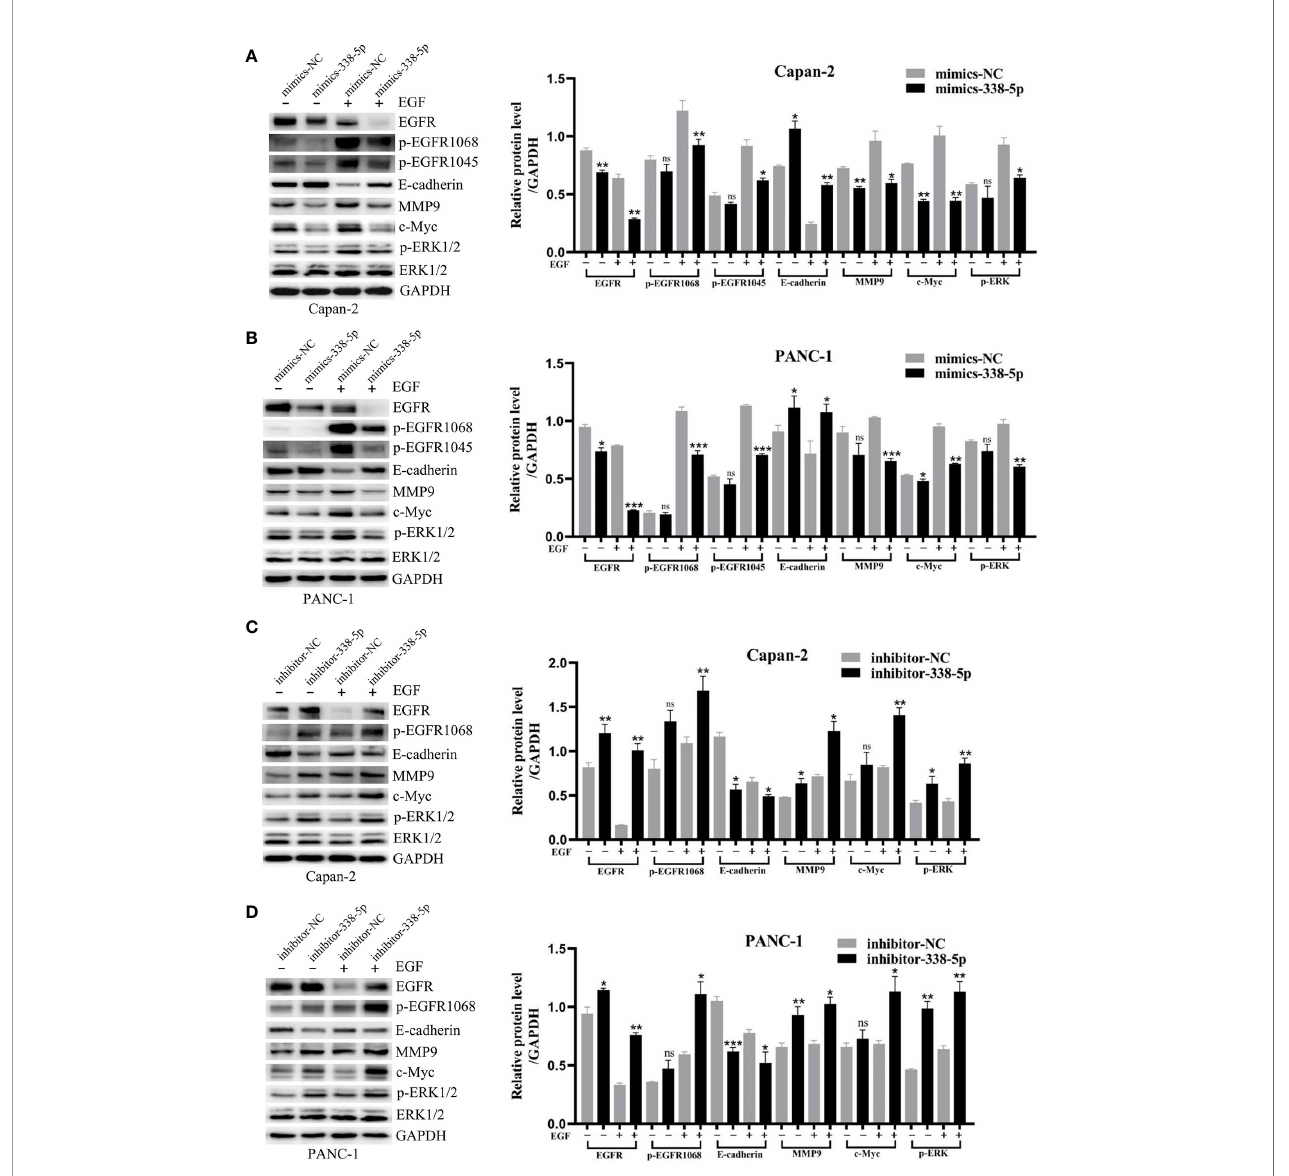
FIGURE 4 | MiR-338-5p inhibited EGF-induced EMT and EGFR/ERK signaling. (A, B) With or without EGF treatment, the protein levels of EGFR/ERK signaling and EMT target genes in mimics NC and mimics-338-5p transfected Capan-2 (A) , and PANC-1 (B) cells detected by western blotting. (C, D) With or without EGF treatment, the protein levels of EGFR/ERK signaling and EMT makers in inhibitor NC and inhibitor-338-5p transfected Capan-2 (C) , and PANC-1 (D) cells detected by western blotting. All data are shown as the mean ± SEM. *P < 0.05; **P < 0.01; ***P < 0.001; ns, no signi fi